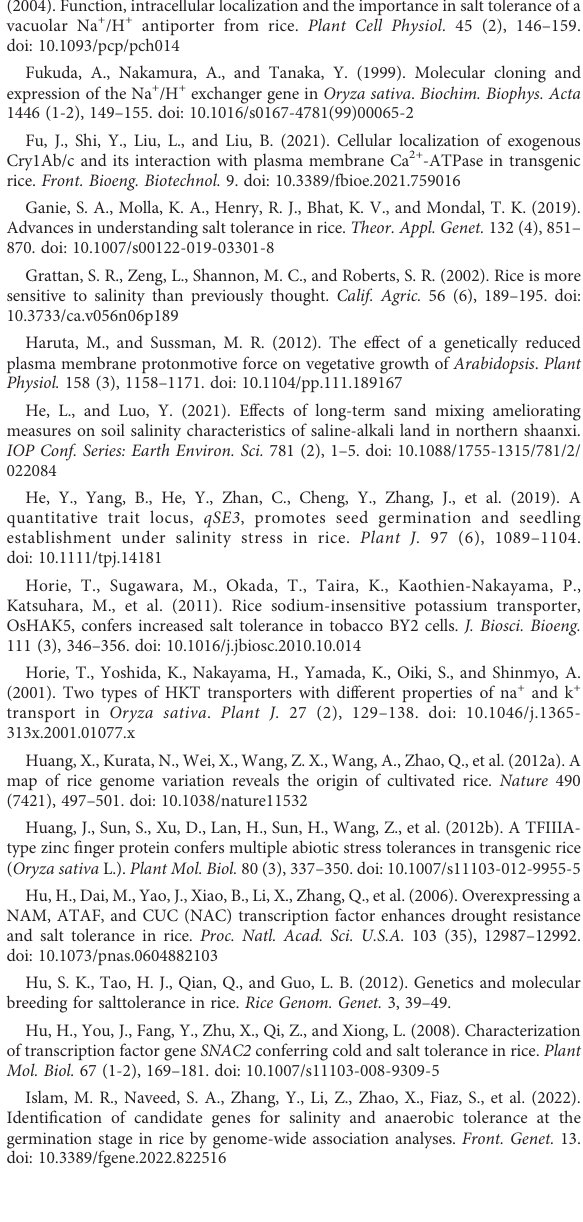
SUPPLEMENTARY FIGURE 1 D K plot for K = 2 – 9. SUPPLEMENTARY FIGURE 2 Average germination potential (GP) on different days under treatment and control. GP on day 3 (3dGP). GP on day 4 (4dGP). GP on day 5 (5dGP). GP on day 6 (6dGP). GP on day 7 (7dGP). ** p < 0.01 (Student ’ s t -test). SUPPLEMENTARY FIGURE 3 Distribution of germination potential (GP) on different days and germination index (GI) under salt stress. ( A ) GP on day 3 (3dGP). ( B ) GP